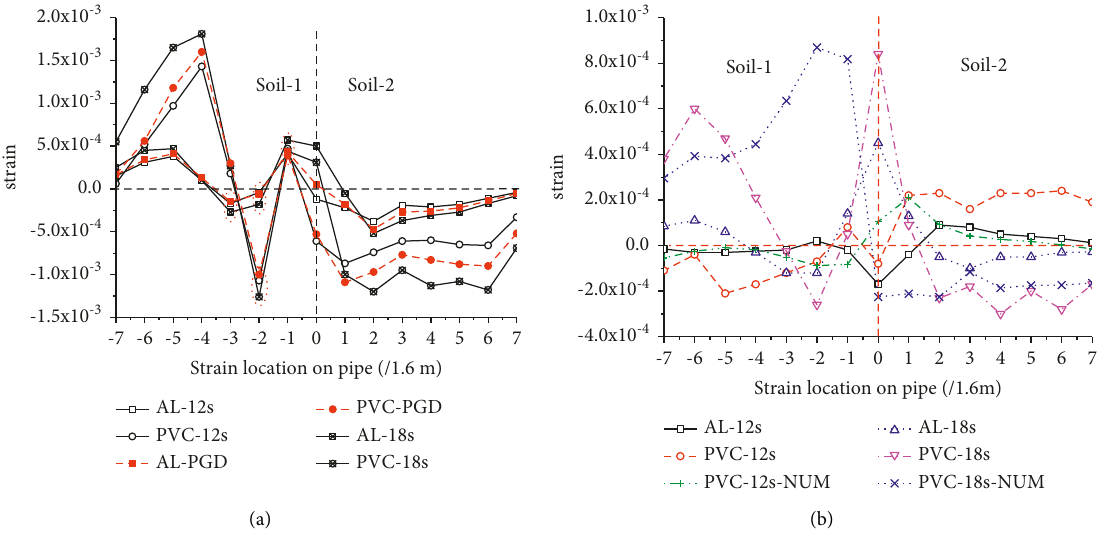
Figure 12: Strain of pipe caused by 0.6g earthquake at 12s and 18s. (a) Strain caused by PGD and TGD (b) strain caused by